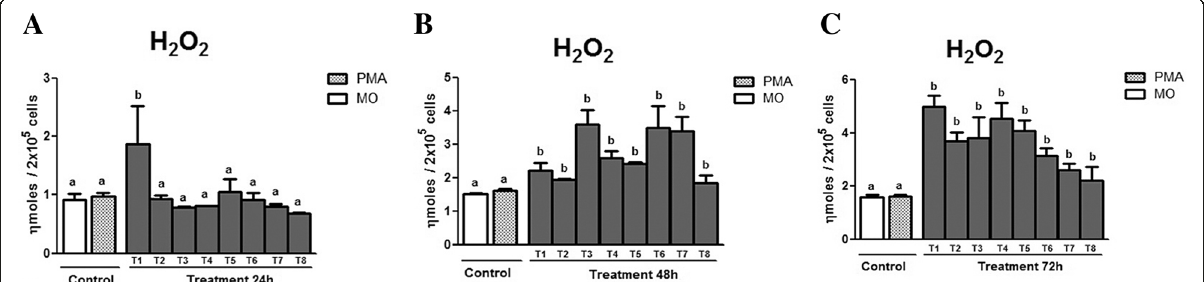
Fig. 6 Means±standard deviation of the mean ( p <0.05) of H 2 O 2 production by peritoneal macrophages of murine macrophages infected by L. (L.) chagasi treated with PLA 2 at three different incubation moments: ( a ) 24 h, ( b ) 48 h, and ( c ) 72 h. The control was performed without treatment (MO) and with stimulation by PMA. The PLA 2 doses utilized in the treatment (T) were T1=100 μ g/mL; T2=50 μ g/mL; T3=25 μ g/mL; T4=12.5 μ g/mL; T5=6.25 μ g/mL; T6=3.125 μ g/mL; T7=1.5625 μ g/mL; T8=0.78125 μ